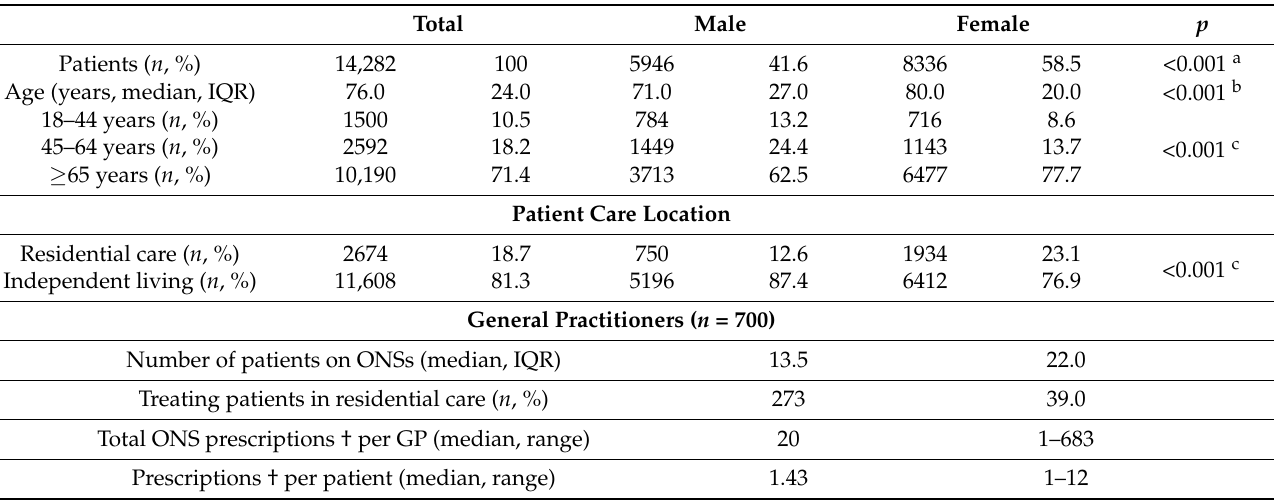
Table 1. Characteristics of patients dispensed oral nutritional supplements and their general practi- tioners over a 12-month